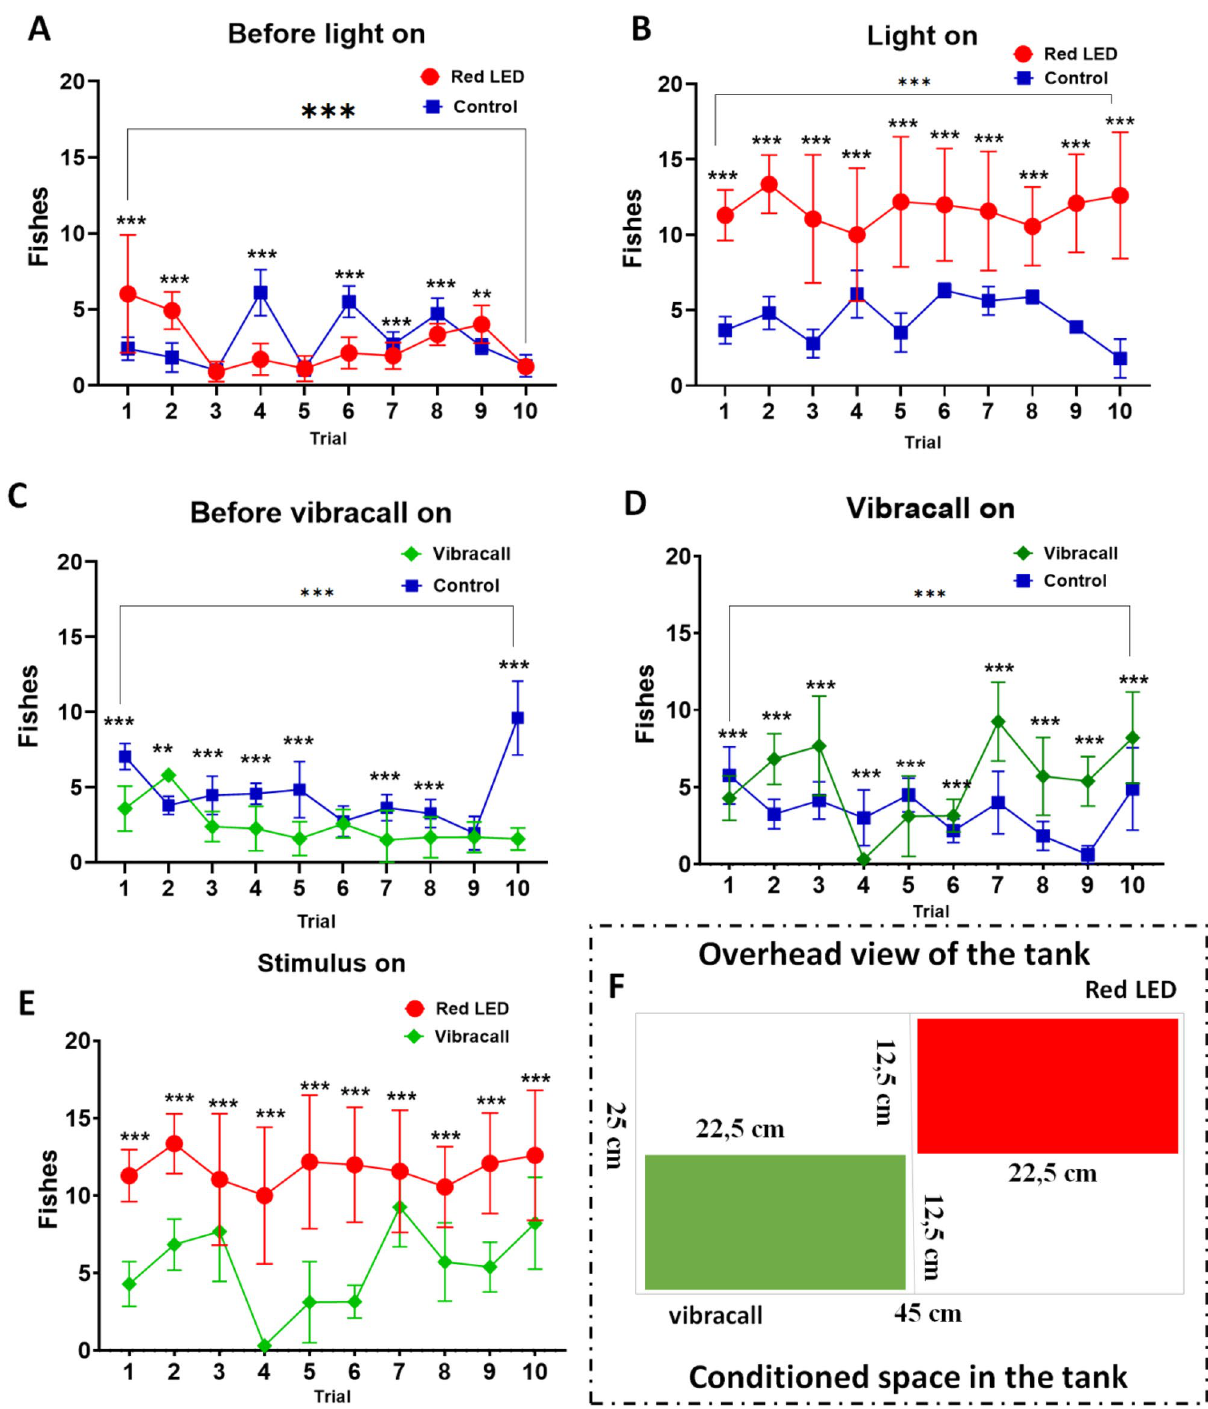
Figure 3. Responses of zebrafish complex appetitive conditioning using two stimuli: red LED light and vibration. ( A ) Number of fish that were in the feeding behavior before the light was turned on. ( B ) Number of fish conditioned with red LED light stimulus during the attempts. ( C ) Number of fish in the food compartment before the vibracall stimulus is activated. ( D ) Number of fish conditioned with vibracall stimulus during the attempts. ( E ) Comparison of the number of fish conditioned by light and vibracall. ( F ) Top view of the tank referring to the conditioning area (red area: red LED and green area: vibracall). The horizontal lines of each group denote the mean ± SD and the asterisks on the brackets indicate statistical difference in comparison with the frequency of fish between the attempt and the control group by student t test (* p < 0.05; ** p < 0.001, *** p <